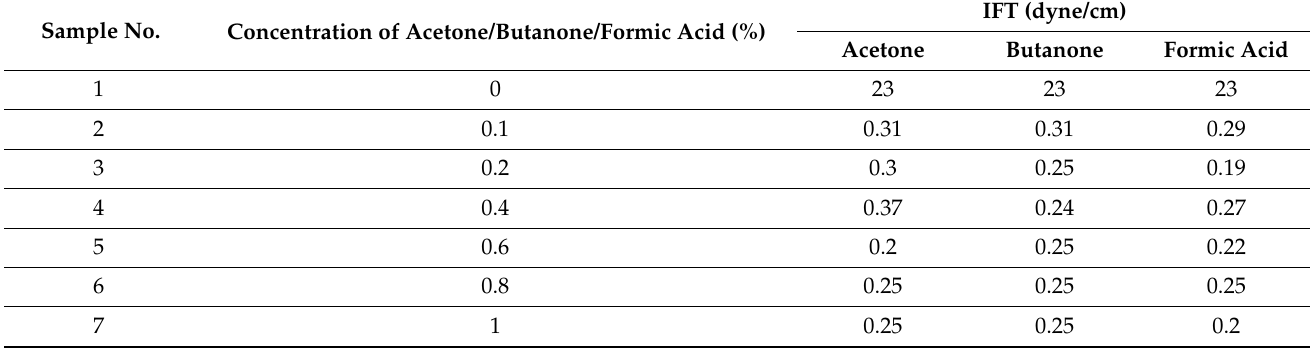
Table 6. Flood results for acetone, APG 264, and Xanthan gum blend.